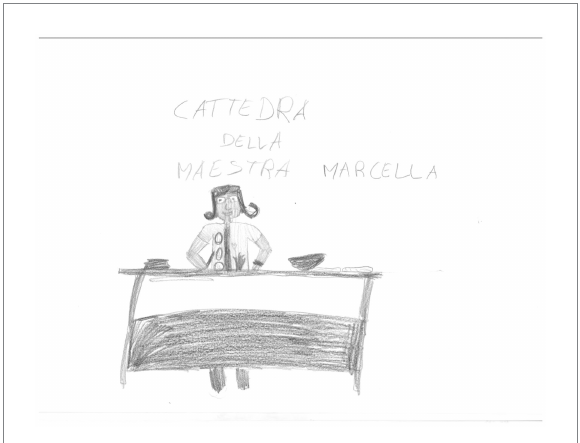
FIGURE 5 Classroom drawing: the presence of the teacher: “ The Teacher Marcella and her desk. ” Female, 10 years